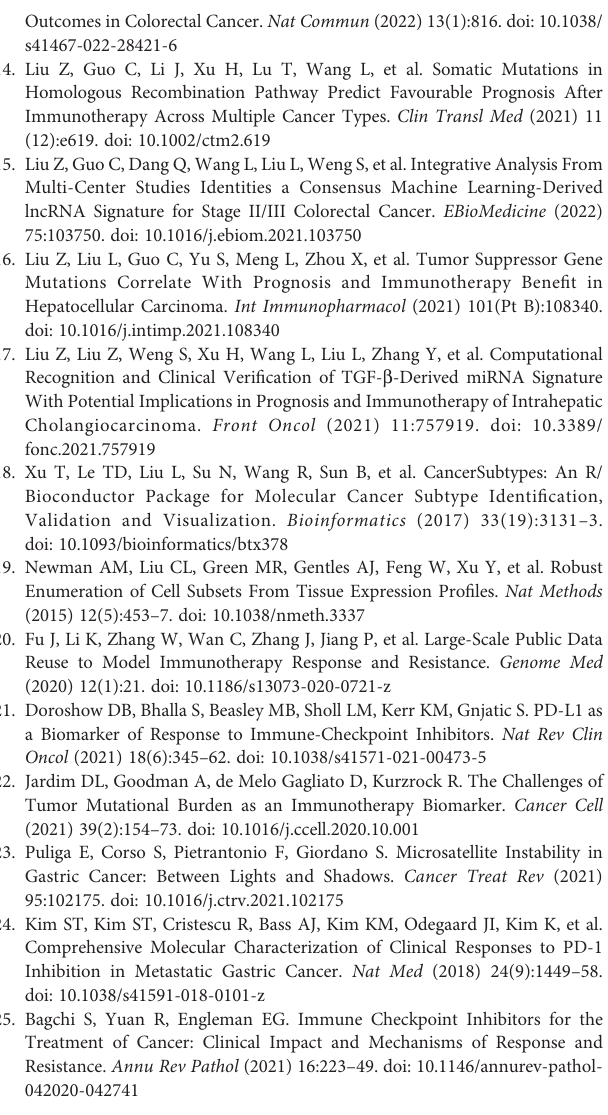
Supplementary Figure 1 | Prognostic and immunologic relevance of RPM. (A – D) Kaplan – Meier analyses of Gene Sets 1 – 4 used to construct the RPM. (E) The TC levels were not signi fi cantly different between RPM-L and RPM-H groups. (F) RPM scores were not signi fi cantly different among different TC levels. (G) Correlation of RPM scores with TMB across 12 cancer types. ns, nonsigni fi